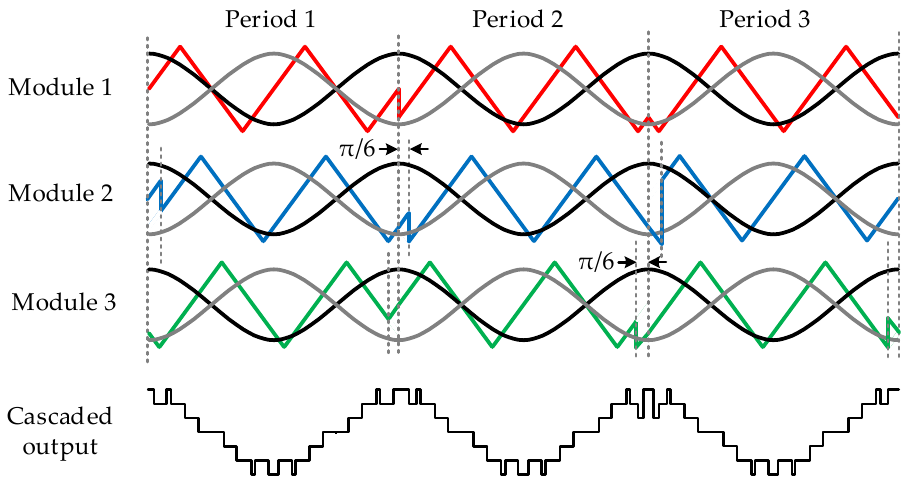
Figure 11. CPRS-PWM scheme with asynchronous rotation time at maximum point of reference. Table 1. Total harmonics distortion (THD) analysis of the cascaded output voltages, shown in Figures 10 and 11.